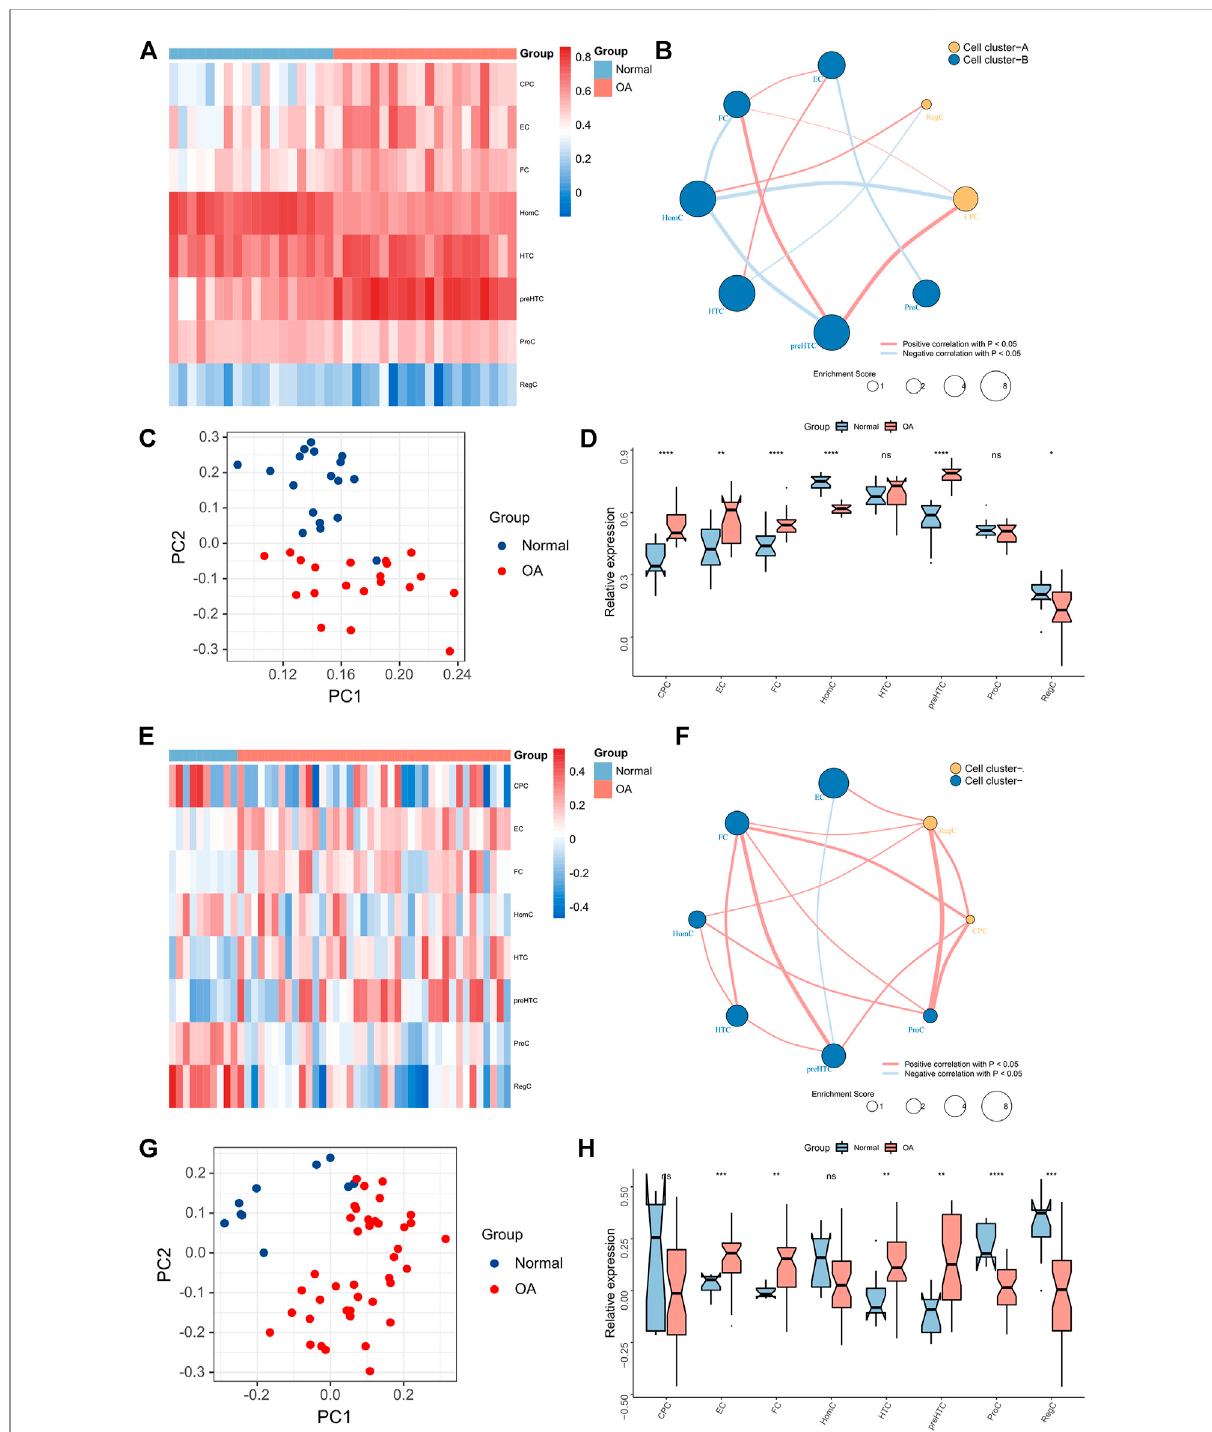
FIGURE 7 Chondrocytespro fi leinBulk-seqdata. (A) TheHeatmapshowingtherelativeabundanceofthe8cellclustersbetweenOAandnormaltissuesin the GSE51588 dataset; (B) The network showing the signi fi cant associations between the 8 cell clusters in the GSE51588 dataset (the dot size represents the total enrichment score of chondrocytes and the clusters are distinguished by color; (C) PCA plot of chondrocytes based on enrichmentscores in theGSE51588 dataset; (D) The box plots showing the relative abundance ofthe 8 cell clusters inOA and normaltissues in the GSE51588 dataset (* p < 0.05, ** p < 0.01, *** p < 0.001; ns, not signi fi cant); (E) The Heatmap showing the relative abundance of the 8 cell clusters between OA and normal tissues in the GSE114007 dataset; (F) The network showing the signi fi cant associations between the 8 cell clusters in the